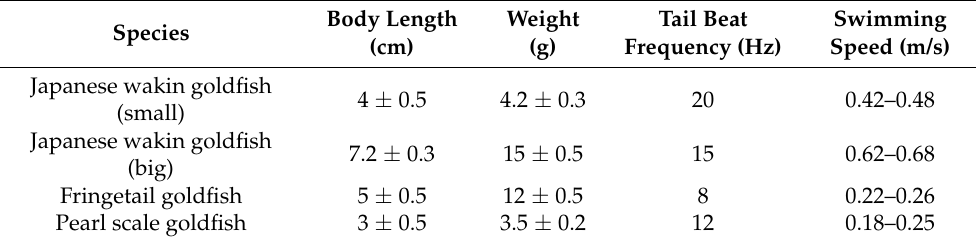
Table 4. Three kinds of experimental